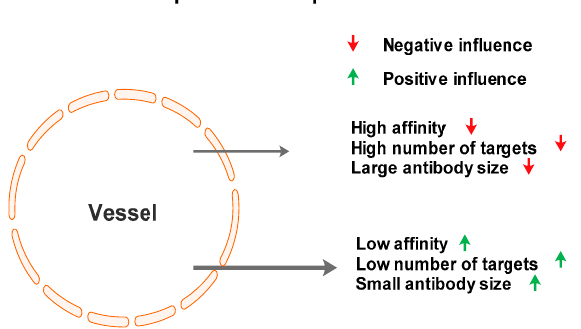
Figure 8. Factors influencing antibody penetration depth in the target tissue, according to Smith [61].